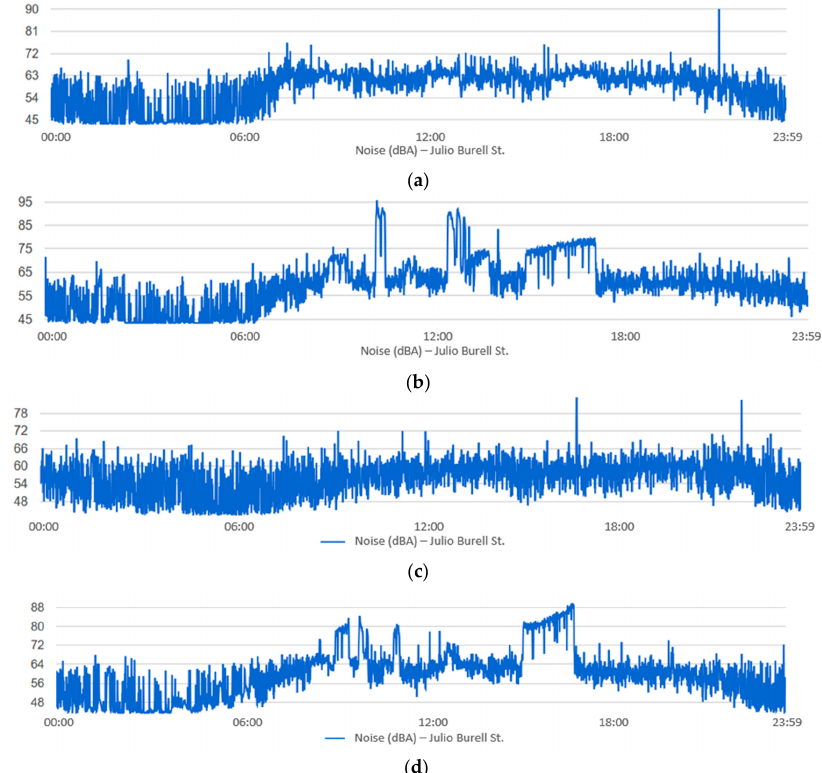
Figure A2. The temporal evolution of the noise at the Julio Burell St. location: ( a ) 15 November 2016,